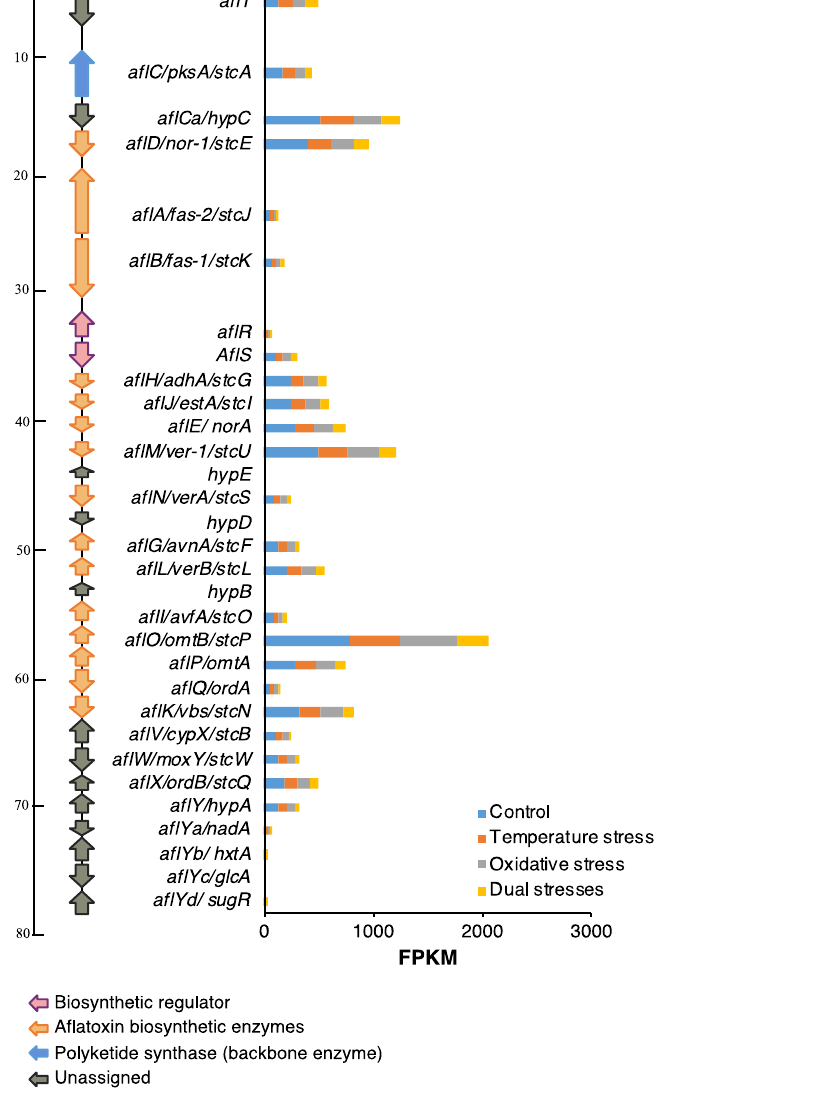
Figure 4. Relative expression of aflatoxin biosynthetic genes. Bars indicate the expression (FPKM) of genes under different treatment conditions. The relative locations of each gene in the aflatoxin biosynthetic gene cluster are shown on the left